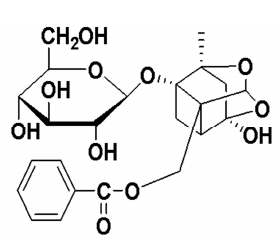
Figure 7. Chemical constitution of paeoniflorin (PF).